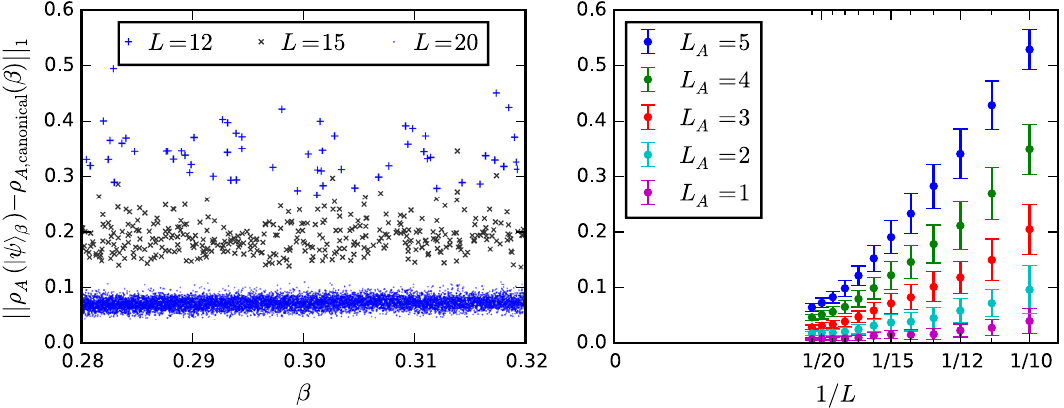
β Þ and the reduced density matrix ρ A; canonical ð 5 . The right panel plots the mean and standard deviation of the trace norm distance in this A ¼ up to A